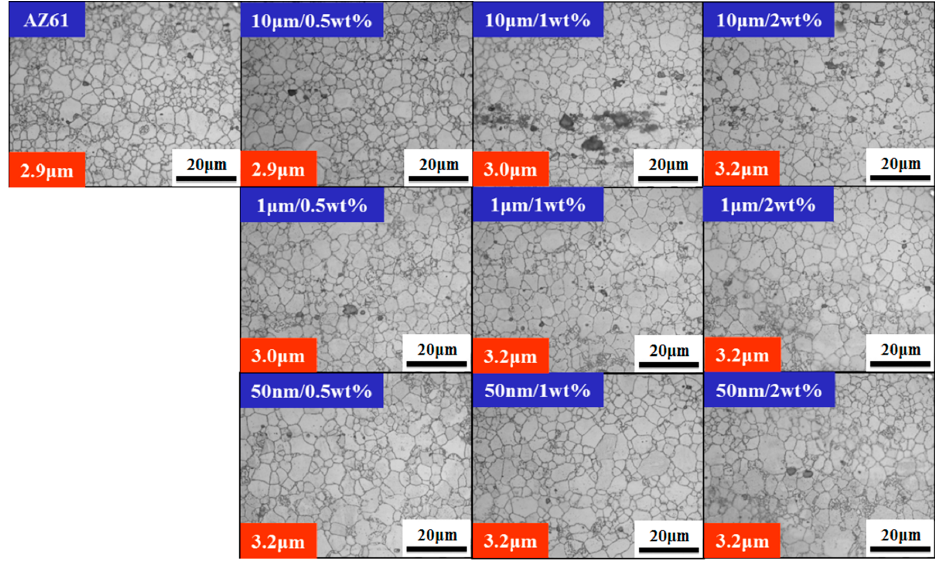
Figure 12. Metallography of the AZ61/SiCp MMC extruded plates after annealing.